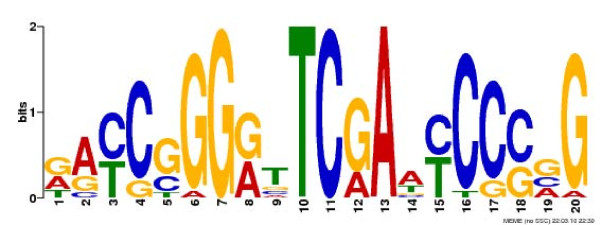
Motif of Ste12-binding sites in yeast. The motif was generated using MEME [30] and the sequences from the putative Ste12-binding regions merged from three biological replicates identified in yeast [31]. The default parameters for MEME were chosen except that motif occurrence was set to ZOOP, minimum width to 8, and maximum width to 20.